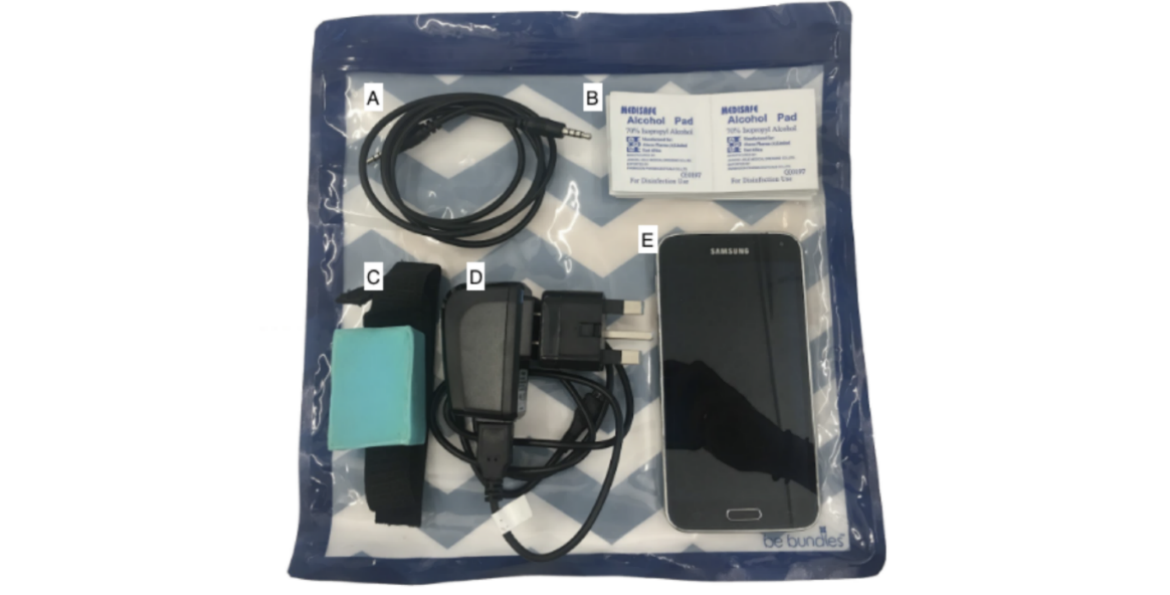
Figure 3. Equipment given to each study participant for the duration of the study: (A) 3.5-mm male-to-male TRRS audio cable, (B) Alcohol wipes,